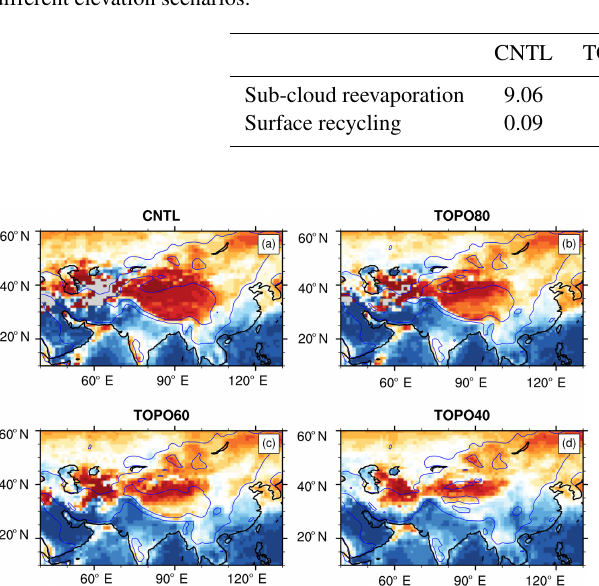
Table 3. The isotopic contribution (in ‰) due to summertime sub-cloud reevaporation and surface recycling on the Tibetan Plateau for different elevation scenarios.